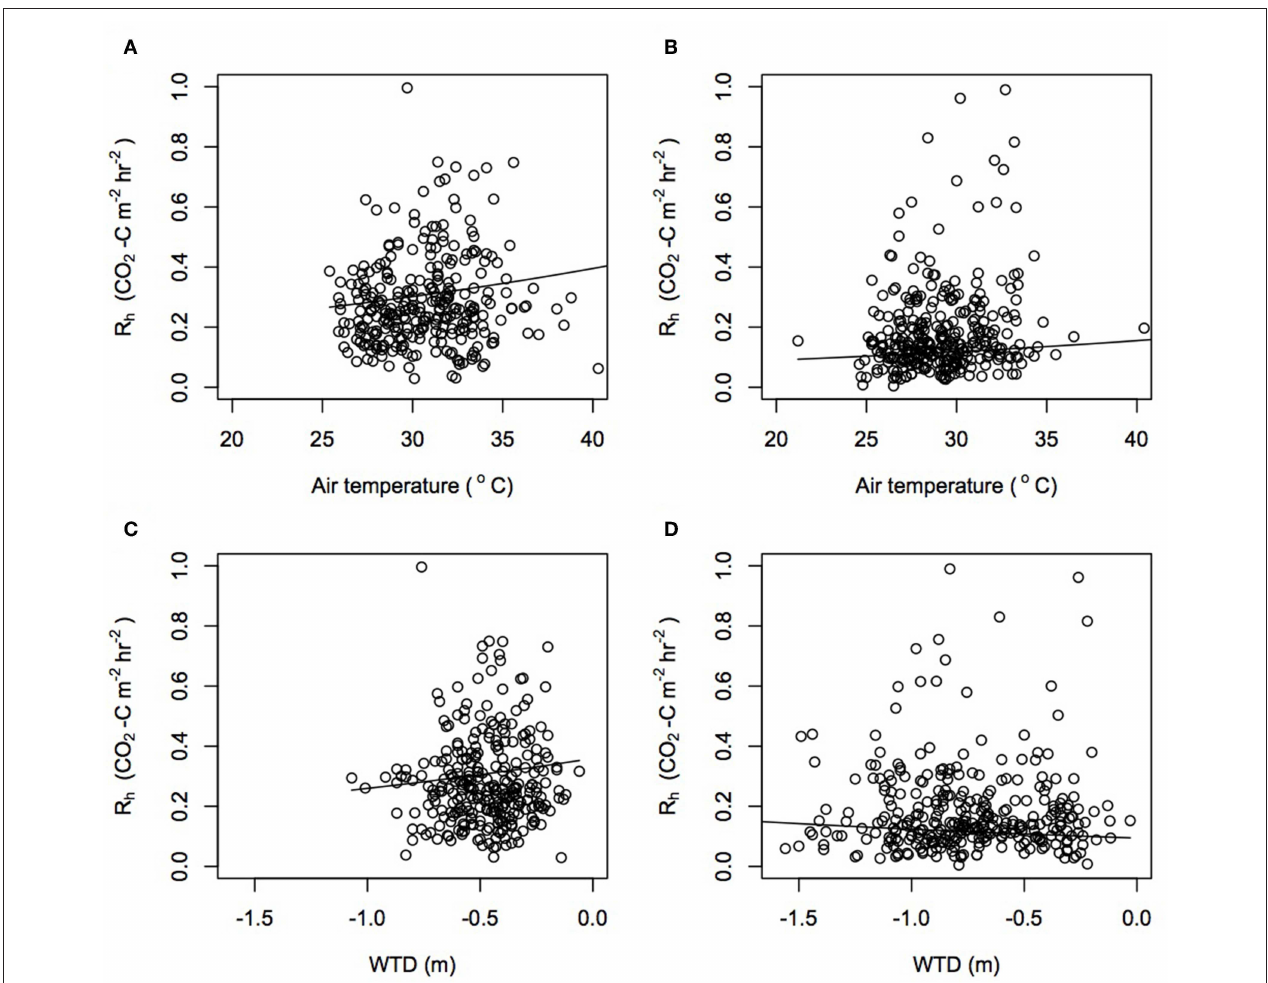
FIGURE 5 | R h estimates modeled from changes in (A) air temperature in Sabaju, (B) air temperature in Sebungan, (C) WTD in Sabaju, and (D) WTD in Sebungan, using the linear mixed effect model parameters. Actual data points from the harvest path, frond pile and cover plants are